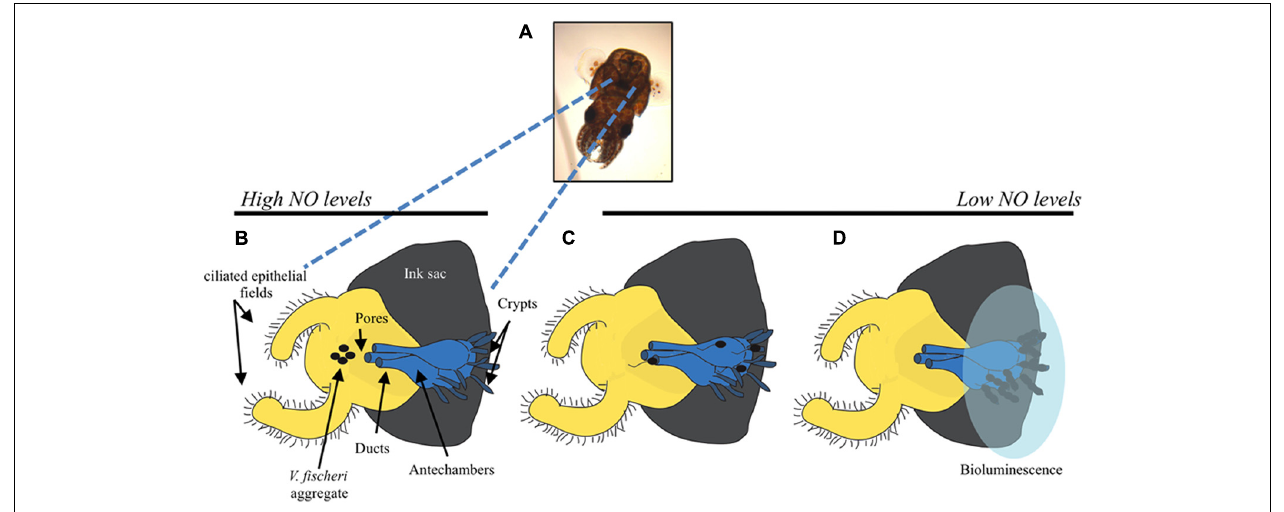
cells form a biofilm-like aggregate around the pores to the light organ. Motility is not required for biofilm formation. (C) After aggregation, V. fischeri cells utilize flagella to migrate into the pores, through the ducts and antechamber, and to establish their niche in the crypt spaces. (D) Once in the crypts, V. fischeri lose their flagella and grow to a sufficient cellular density that allows for the induction of bioluminescence genes (transparent blue oval represents luminescence). Figure modified from Nyholm and McFall-Ngai